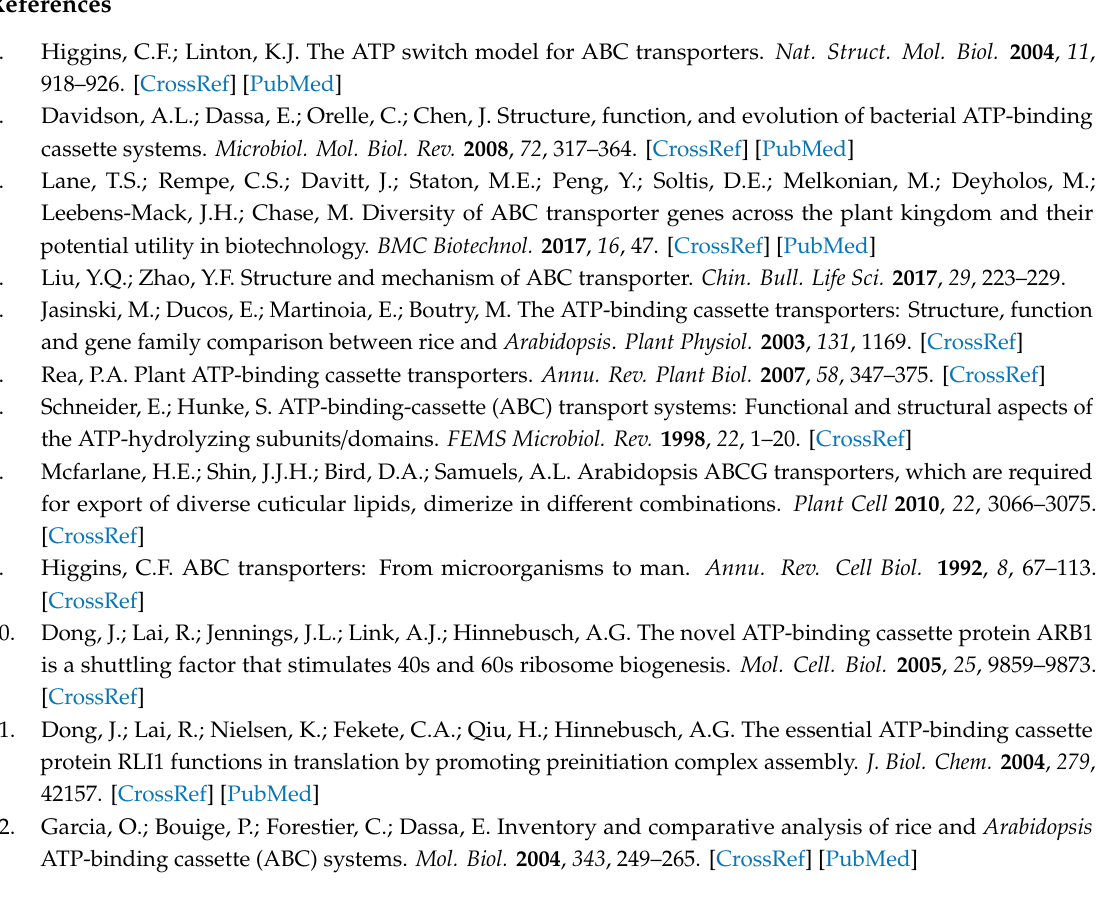
Figure S1. Intron-exon structures of the ABC genes in barley. Analysis of HvABC genes structure using GSDS online tool. Yellow boxes indicate the coding sequences (CDS), blue rectangles indicate UTR, while black lines indicate introns. Figure S2. The motif analysis of ABC family in barley. Seven conservative motifs were identified and were represented by di ff erent colors. The black solid line represents the corresponding HvABC protein and its length. The position of the motif on the sequence was labeled. Table S1: Physicochemical properties, domain and subcellular localization of ABC proteins in